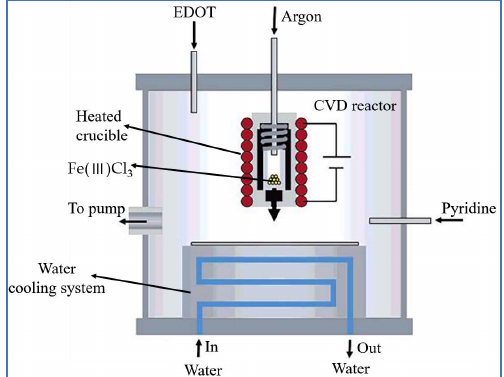
Figure 5. Schematic of preparation process of the conducting PEDOT films via CVD [111].